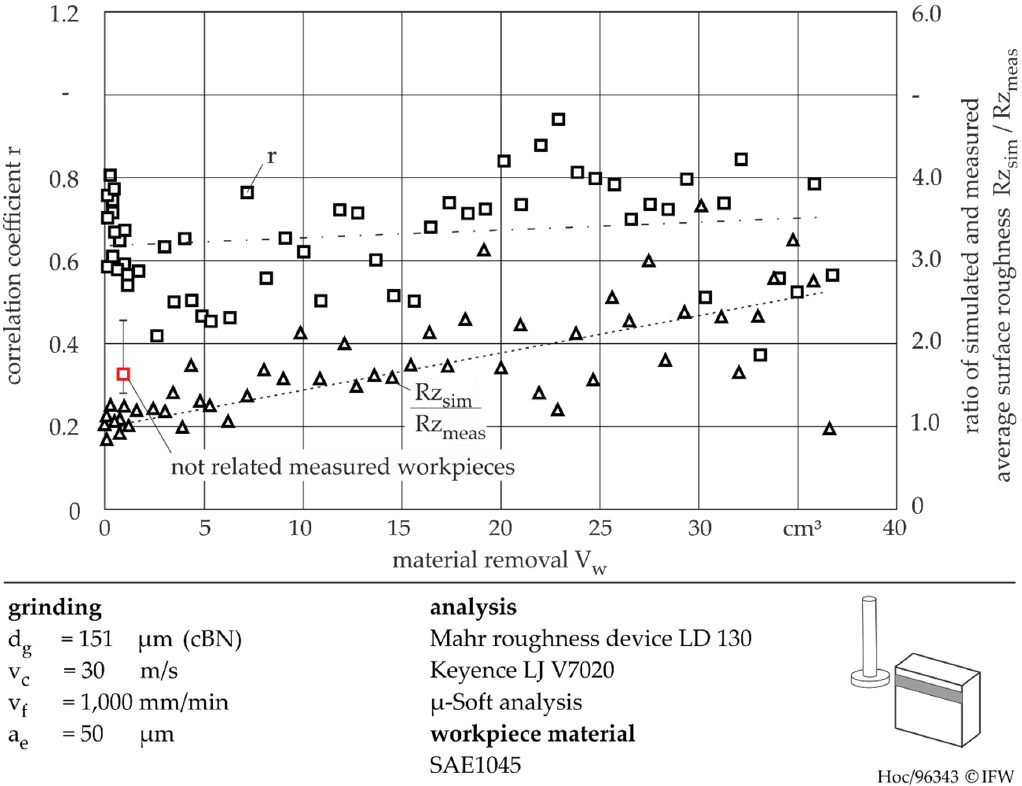
Figure 8. Comparison between simulated and measured workpiece topography by means of the average surface roughness Rz and the correlation coefficient r.